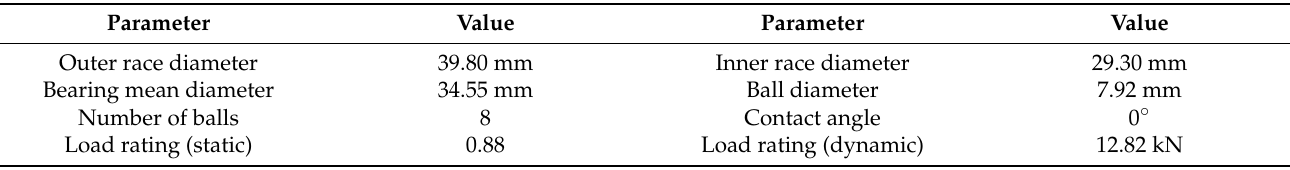
Figure 20. Photos of tested bearings: ( a ) normal bearing; ( b ) inner race wear; ( c ) outer race wear; ( d ) outer race fracture.